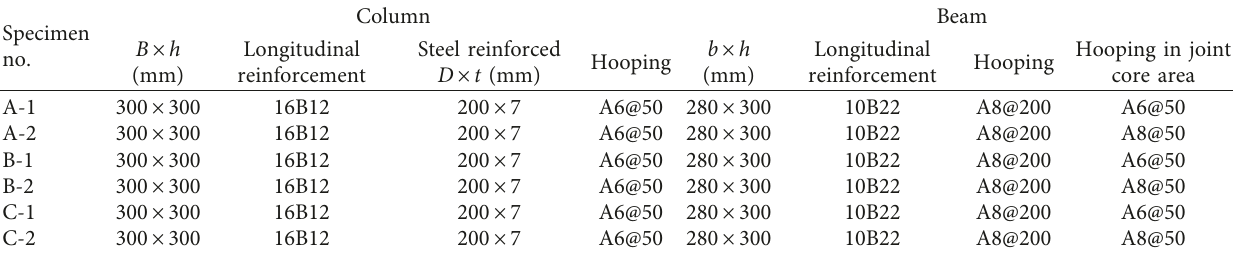
Table 1: Size and structure of specimens.